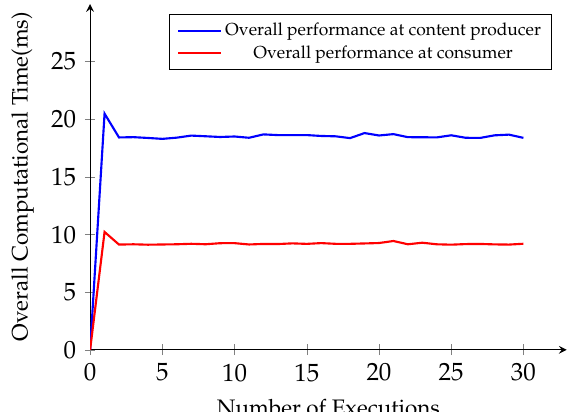
Figure 8. Average overall computational time.